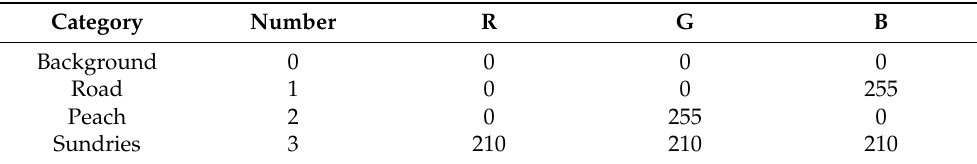
Table 1. Orchard environment category label information.